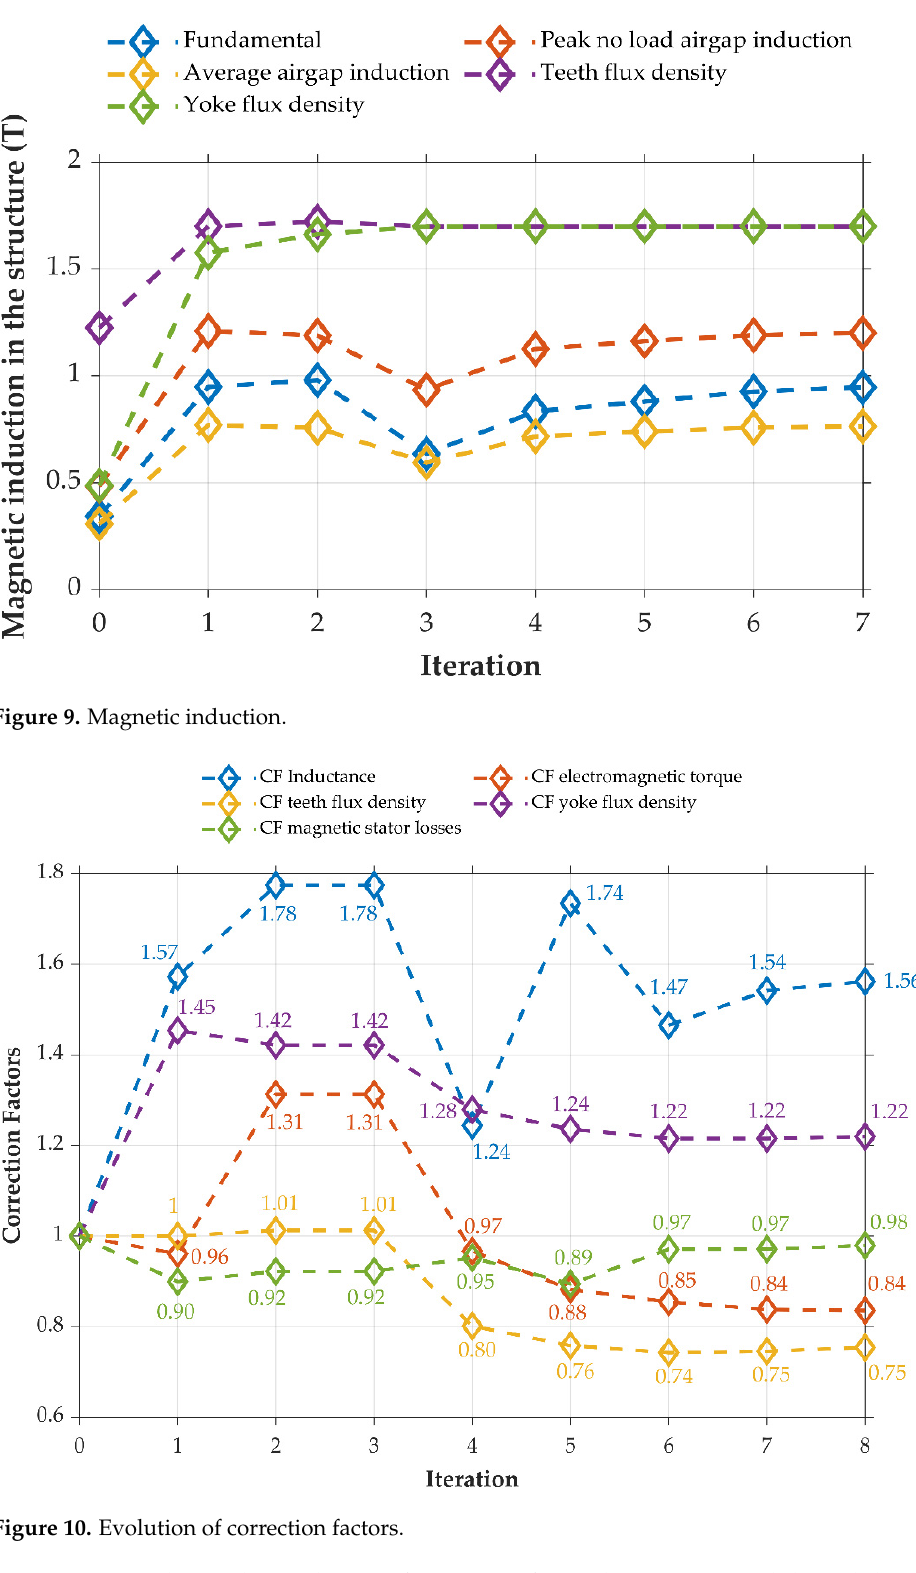
Figure 11. Electromagnetic torque of the machine.